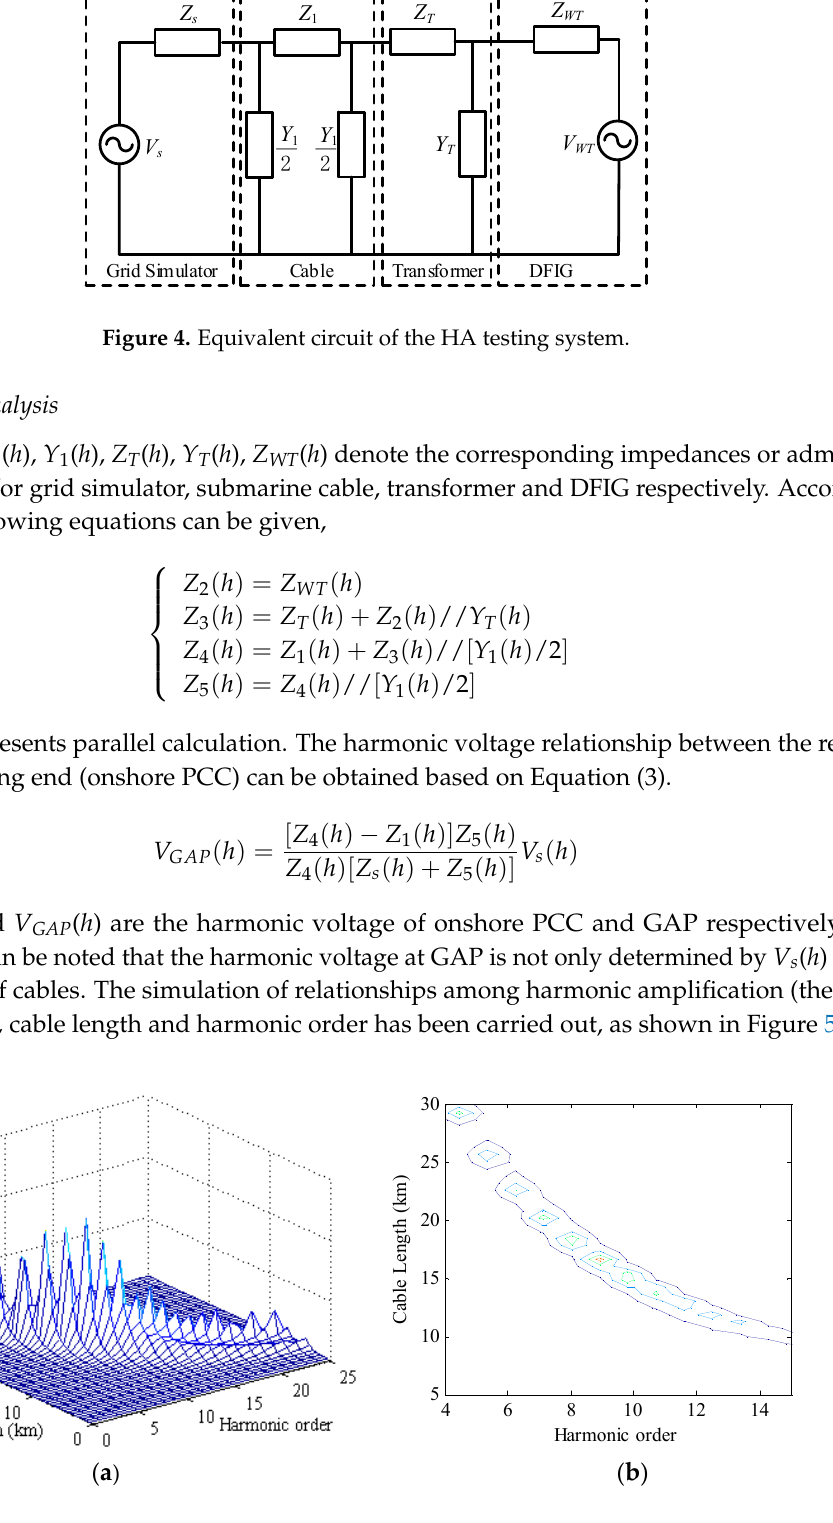
Figure 5. Simulation results of Equation (4). ( a ) Relationships among harmonic amplification, cable length and harmonic order; ( b ) relationships among harmonic amplification, cable length and harmonic order shown by contour map.